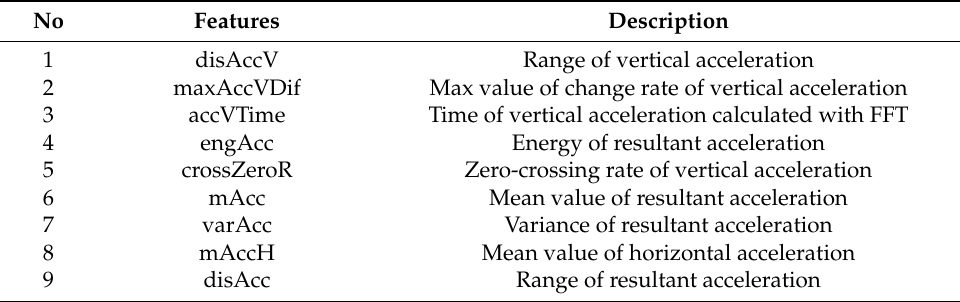
Table 1. Features for activity